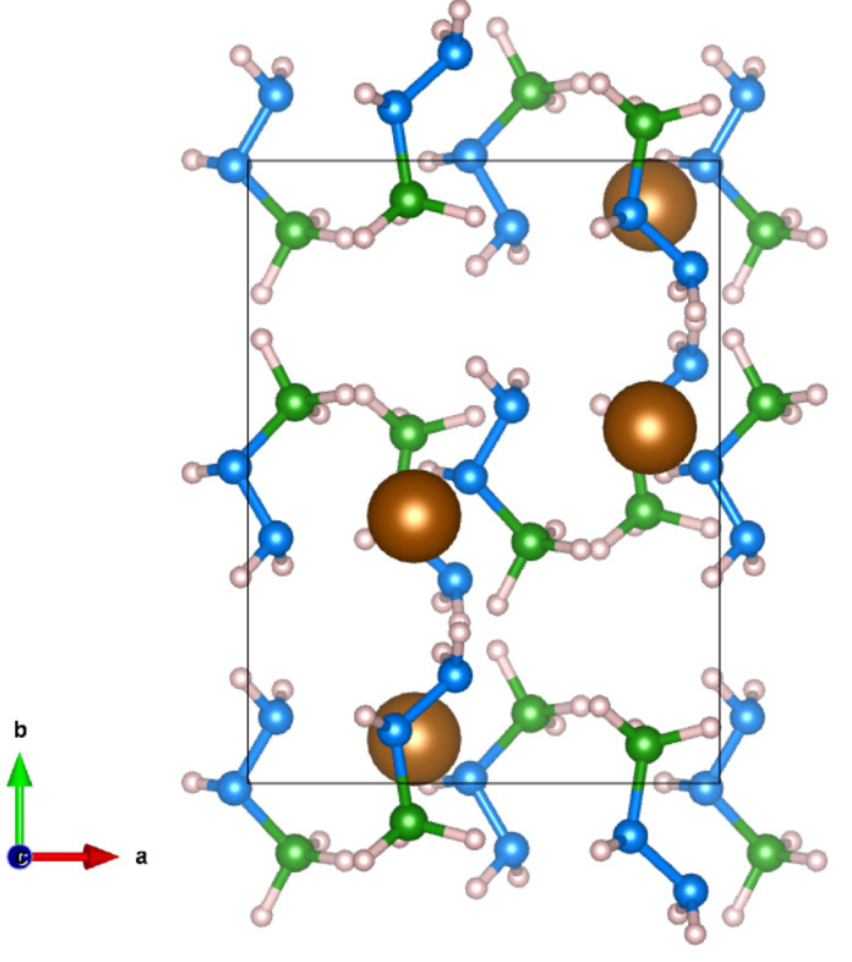
Figure 20. Crystal structure of Ca(HB) 2 along the [001] direction. The H, B, N and Ca atoms are represented by pink, green, blue and brown spheres, respectively.